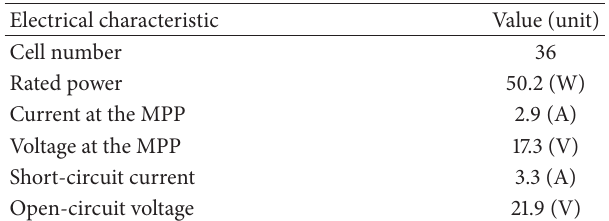
Table 1: Specification of SM50 PV module at standard test condi- tions (STC).